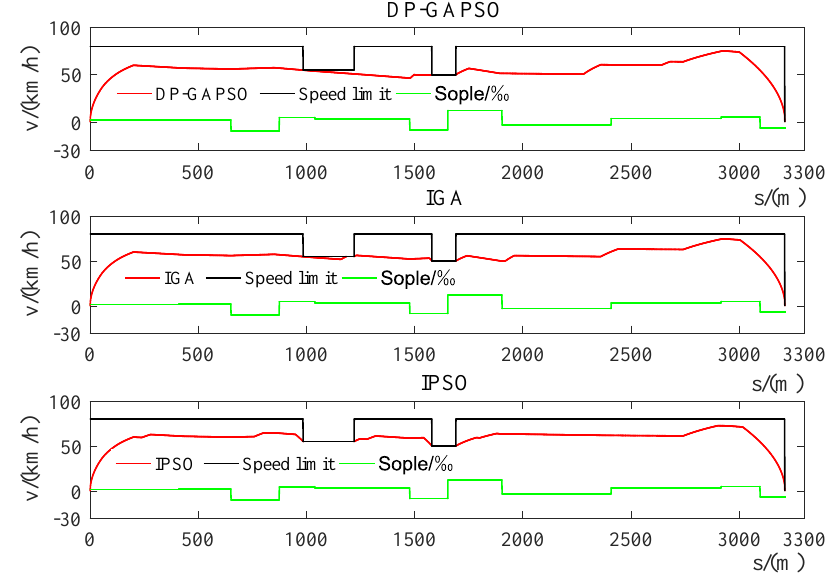
Figure 15. The speed distance curve of the train from Dalian North Station to Houyan.